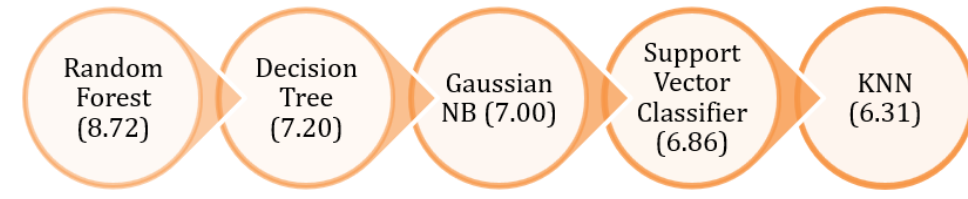
Figure 10. Machine learning classifier ranking based on mean achieved after applying 10-K fold.